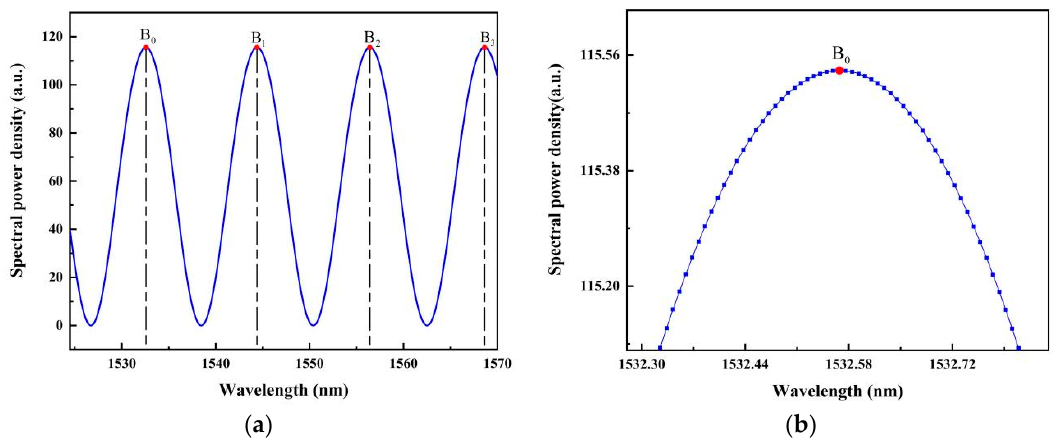
Figure 7. ( a ) Calculation of the cavity length using two neighboring apexes based on the peak-to-peak method; ( b ) enlarged view of the reflection spectrum at the wavelength position of one peak. B 0 , B 1 , B 2 , and B 3 are four reflection peaks.